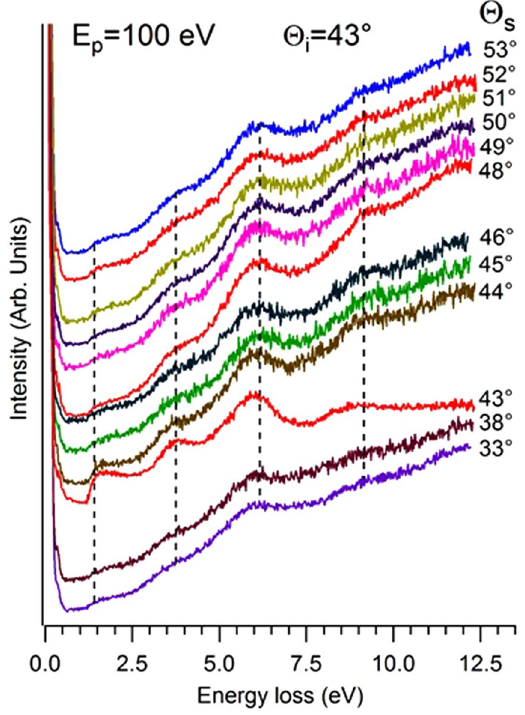
Figure 4. EELS spectra at different values of the scattering angle θ s , The corresponding range spanned in the momentum domain is 0–0.79 Å − 1 . The impinging energy is 100 eV.